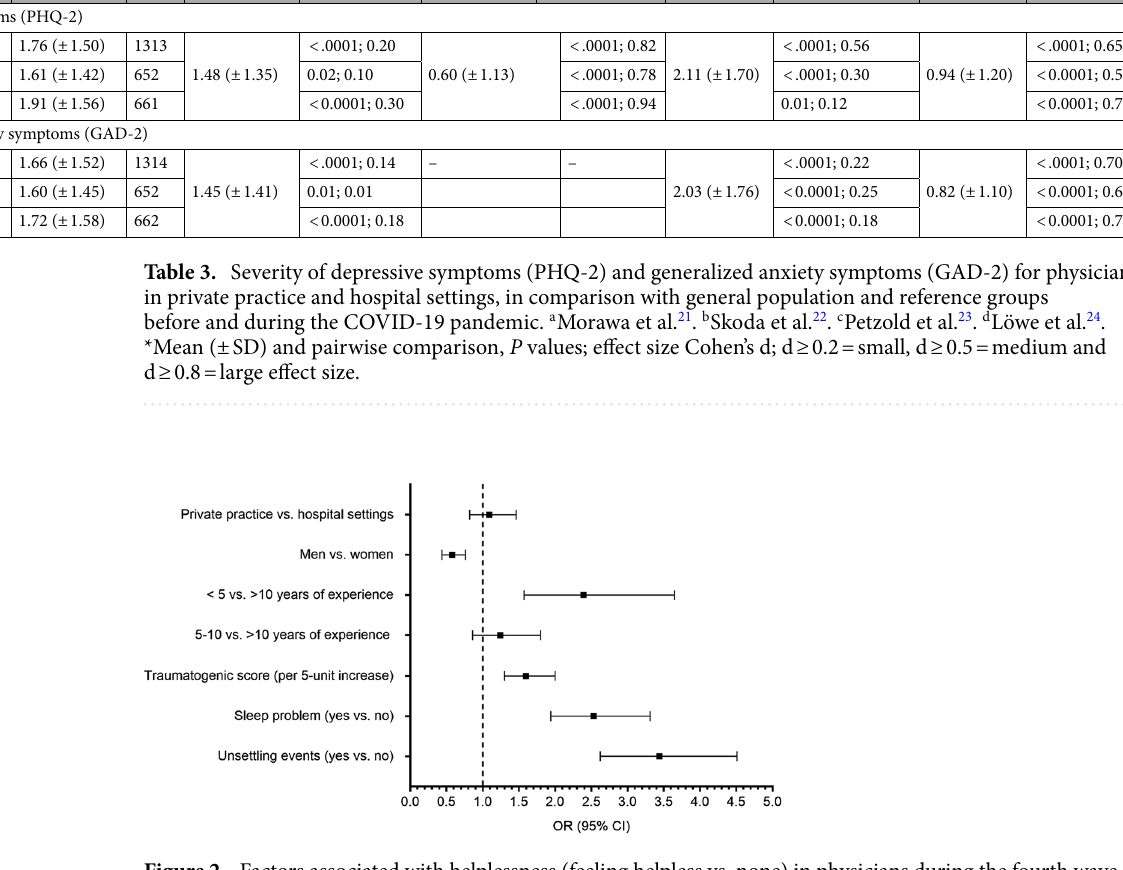
Figure 2. Factors associated with helplessness (feeling helpless vs. none) in physicians during the fourth wave of COVID-19 pandemic (N = 1315). *Depicted are Odds Ratios (OR), 95% Confidence Intervals (CI) and P values estimated from multivariate logistic regression.